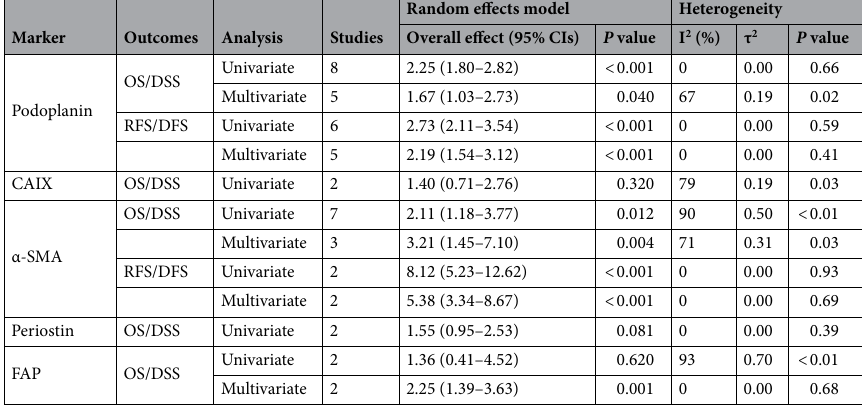
Table 1. Summary of results from the random effects models for individual